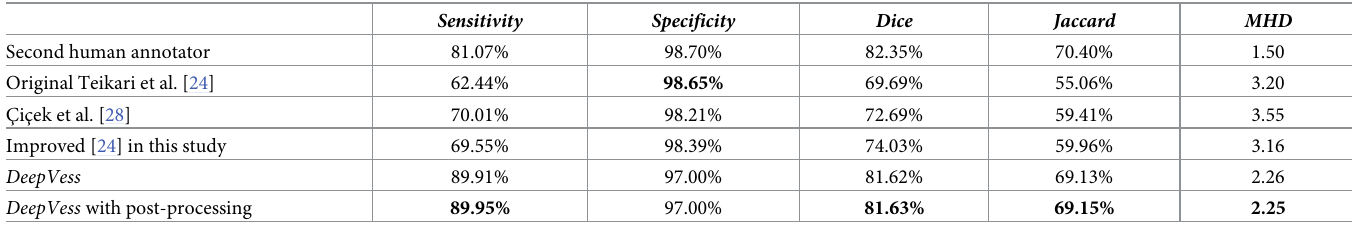
Table 1. The comparison of our proposed CNN architecture ( DeepVess ), manual annotation by a trained person, and two state-of-the-art methods [24, 28] to the gold standard of the expert human annotation based on the 4-fold cross-validation results. DeepVess surpassed both human annotator and two state-of-the-art meth- ods in terms of sensitivity as well as Dice index, Jaccard index, and boundary modified Hausdorff distance, which are the three metrics that are widely used in